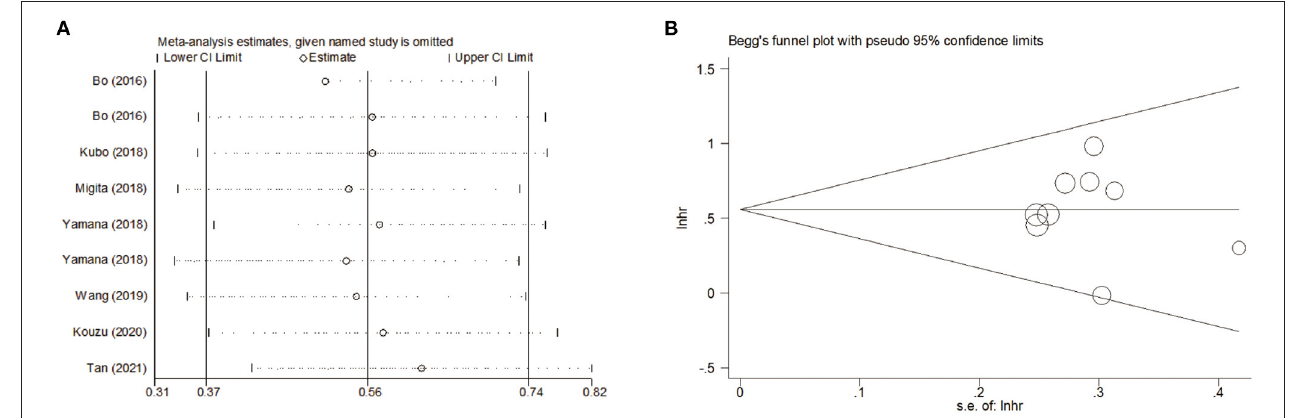
FIGURE 6 | (A) Sensitivity analysis for meta-analysis of GNRI. (B) Funnel plots of publication bias for meta-analysis of GNRI.